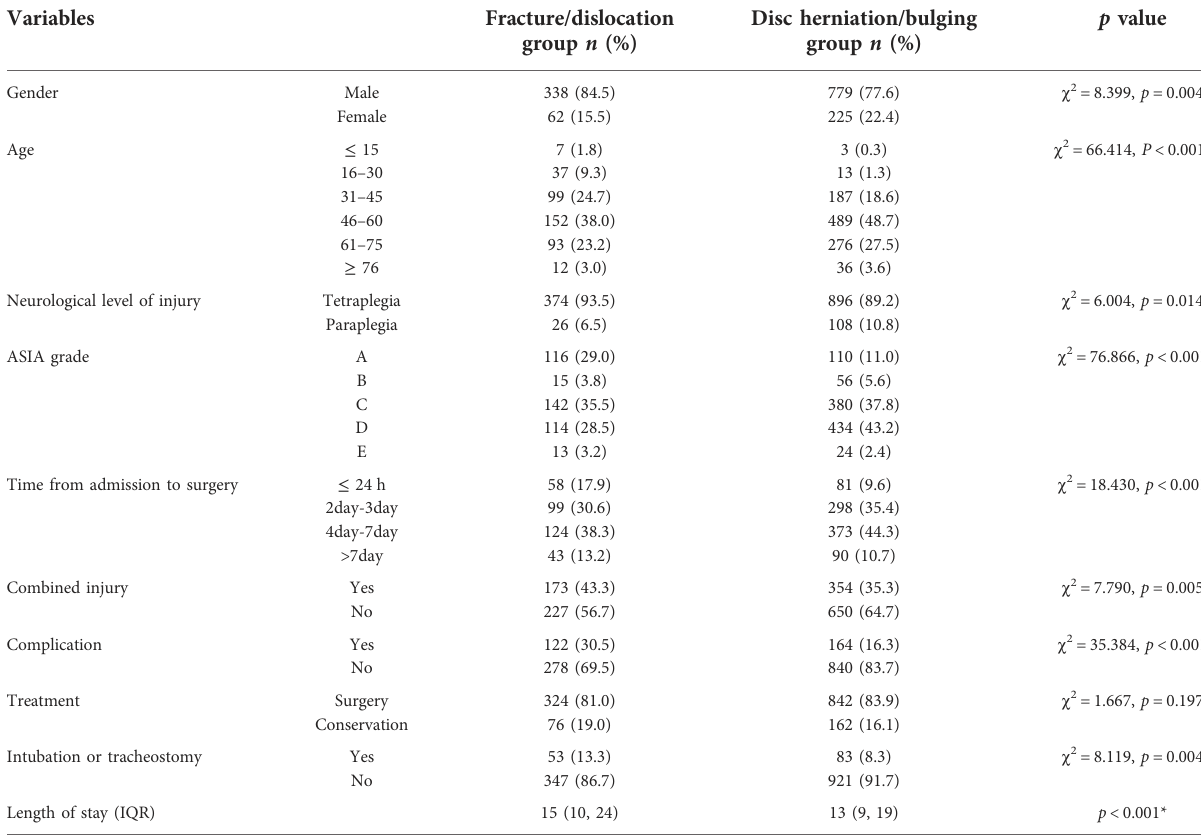
TABLE 6 Characteristics of 1,404 patients caused by fracture/dislocation and disc